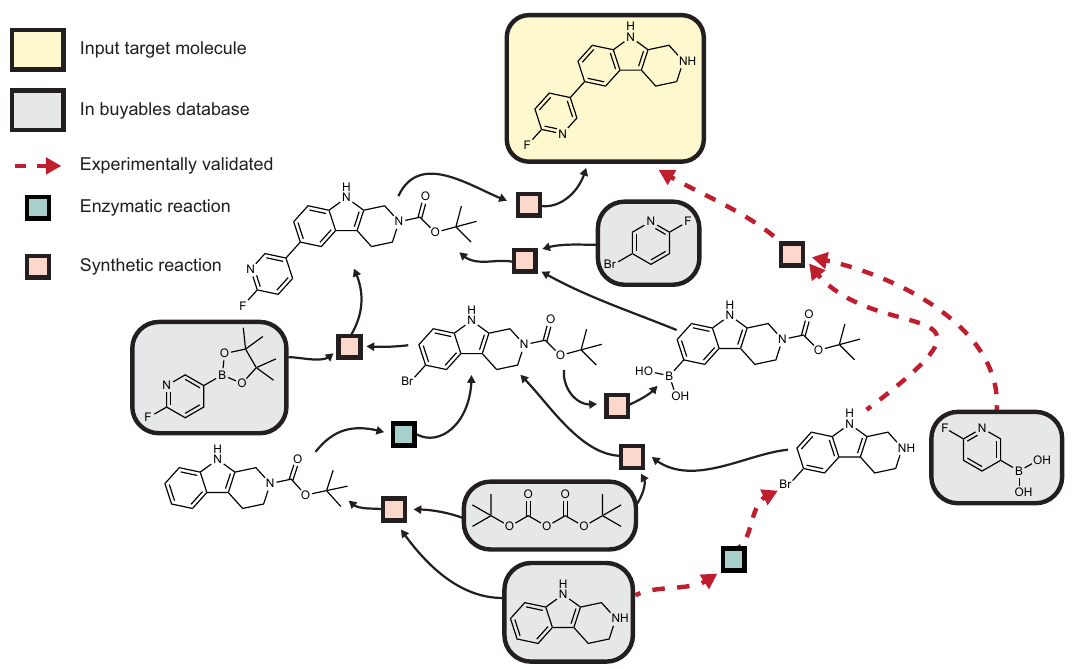
removed from the graph for visual clarity. The recovered experimentally validated pathway from ref. 56 is highlighted with red